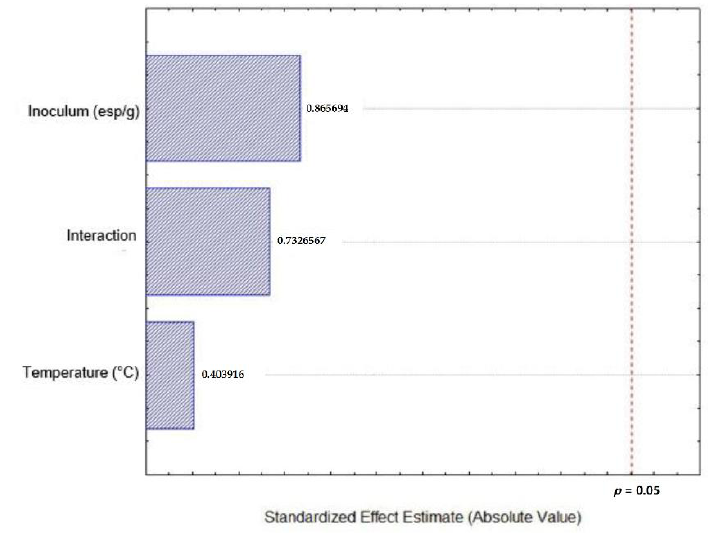
Figure 2. Pareto chart for total polyphenols from the Box Hunter &Hunter design analysis.